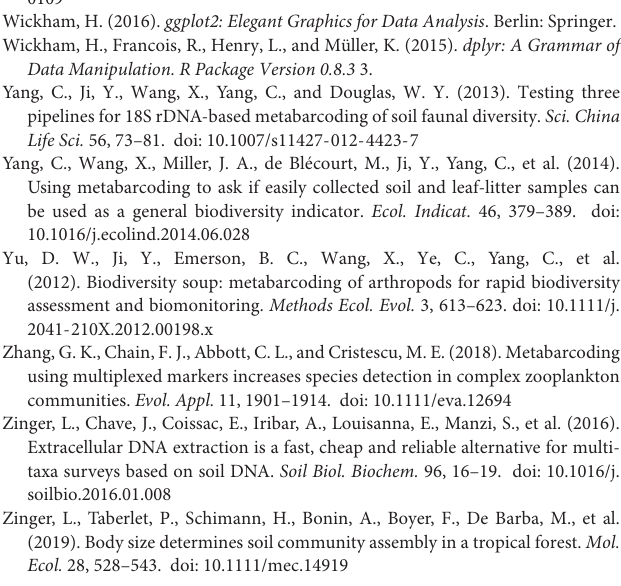
Taberlet, P., PRUD’HOMME, S. M., Campione, E., Roy, J., Miquel, C., Shehzad, W., et al. (2012). Soil sampling and isolation of extracellular DNA from large amount of starting material suitable for metabarcoding studies. Mol. Ecol. 21, 1816–1820. doi: 10.1111/j.1365-294x.2011.05317.x Tang, C. Q., Leasi, F., Obertegger, U., Kieneke, A., Barraclough, T. G., and Fontaneto, D. (2012). The widely used small subunit 18S rDNA molecule greatly underestimates true diversity in biodiversity surveys of the